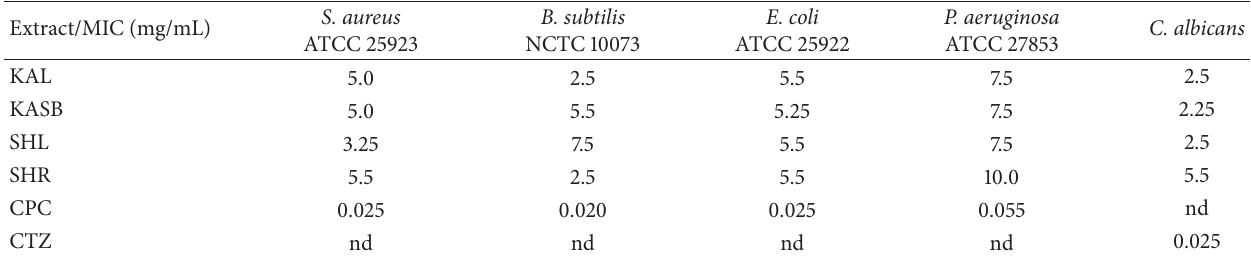
Table 2: Minimum inhibitory concentrations (MICs) of methanol leaf extract (KAL) and stem bark extract (KASB) of K. africana and leaf extract (SHL) and root extract (SHR) of S. hispidus determined by microdilution method. The experiments were repeated three